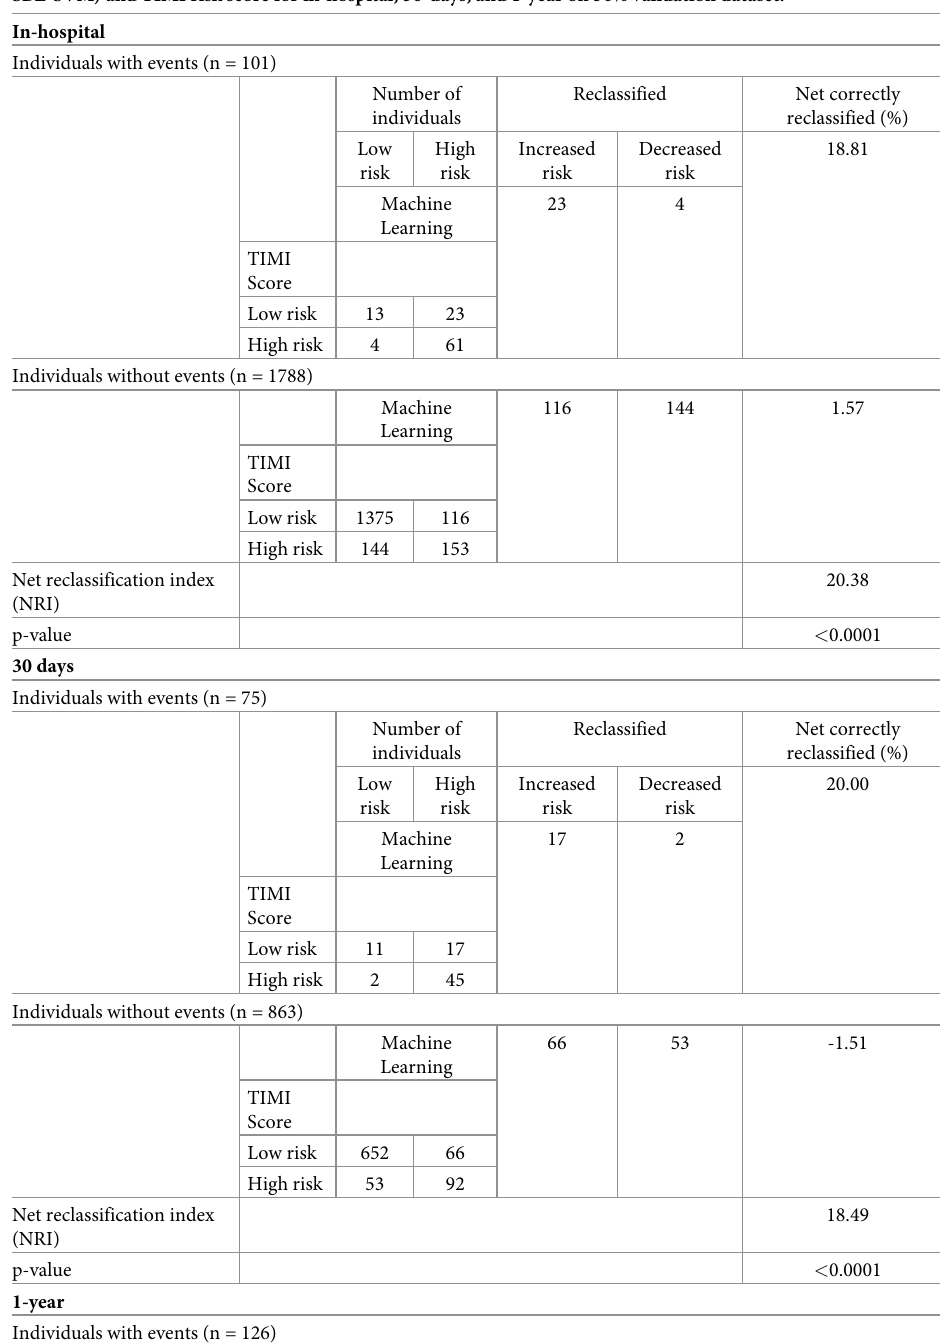
Table 5. Predicted risks and reclassification of STEMI patient’s mortality between ML best model (SVMvarImp- SBE-SVM) and TIMI risk score for in-hospital, 30-days, and 1-year on 30% validation